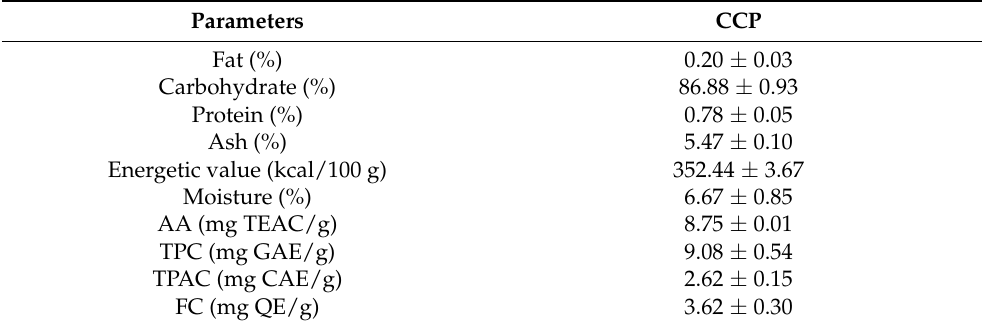
Table 1. Composition, energetic value, antioxidant activity, and polyphenolic compounds of Cor- nelian cherry powder.